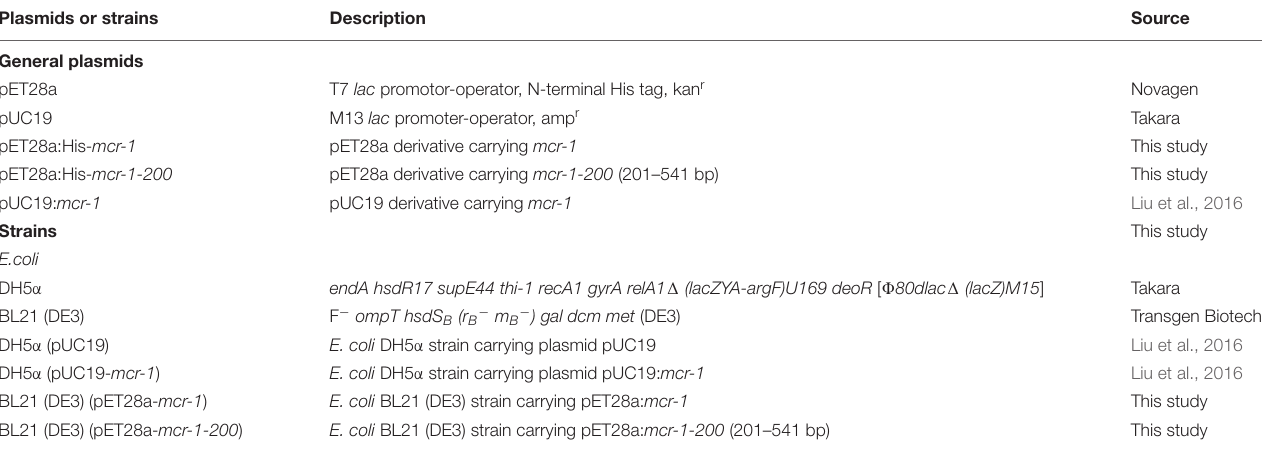
TABLE 1 | Bacterial strains and plasmids used in this